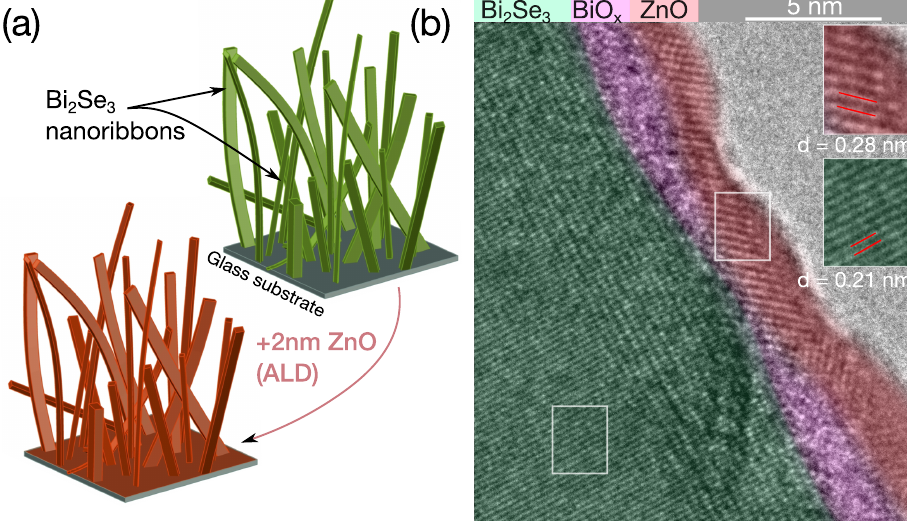
Figure 1. ( a ) Schematic representation of catalyst-free PVD-synthesized free-standing Bi 2 Se 3 nanorib- bons on glass substrate; ( b ) false-colored HR-TEM image of a Bi 2 Se 3 nanoribbon after encapsulation with a thin layer of